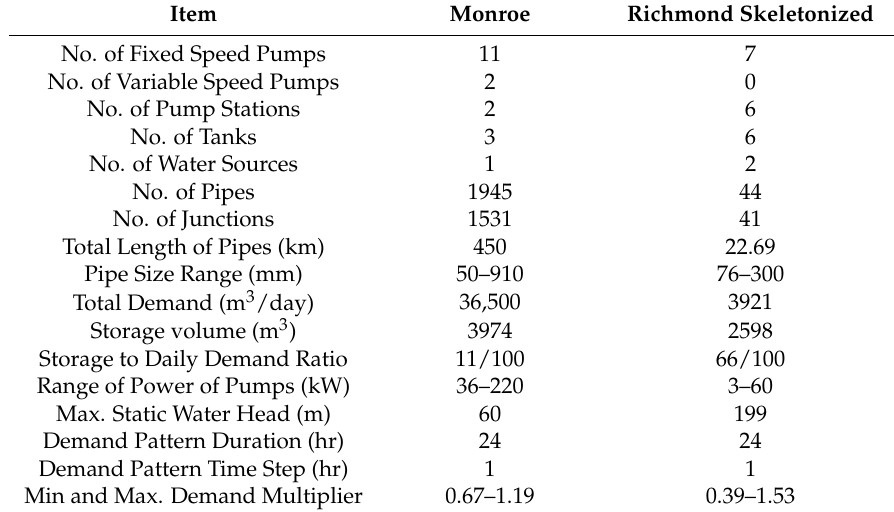
Table 1. Summary of the detailed model of Monroe and Skeletonized model of Richmond water distribution systems